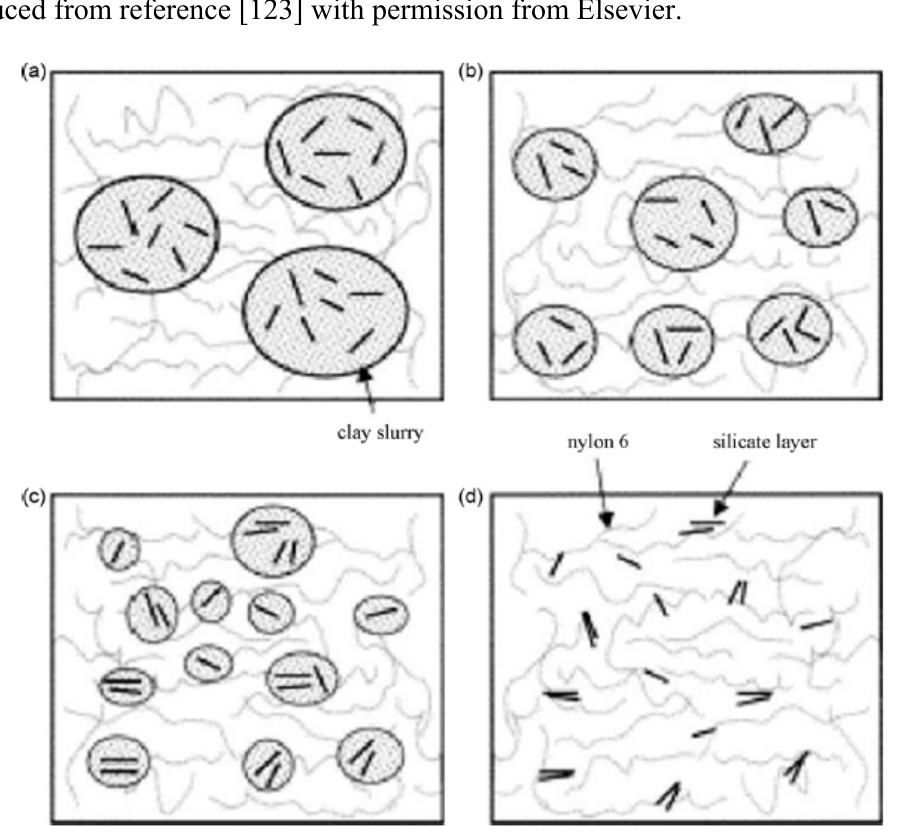
Figure 24. Dispersion of aqueous slurry of sodium montmorillonite in polyamide 6. Reproduced from reference [123] with permission from